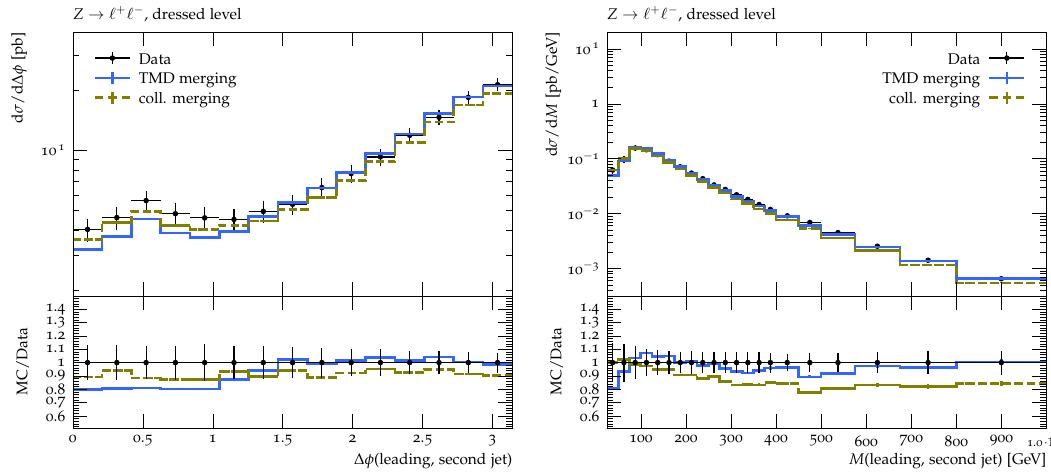
Figure 26 . Predictions obtained using Madgraph + Pythia 6 with MLM merging and the TMD merging framework are compared for the di-jet azimuthal separation (left) and di-jet mass (right) distributions for Z + ≥ 2 jets events. The phase space for the calculation follows the one in [91].